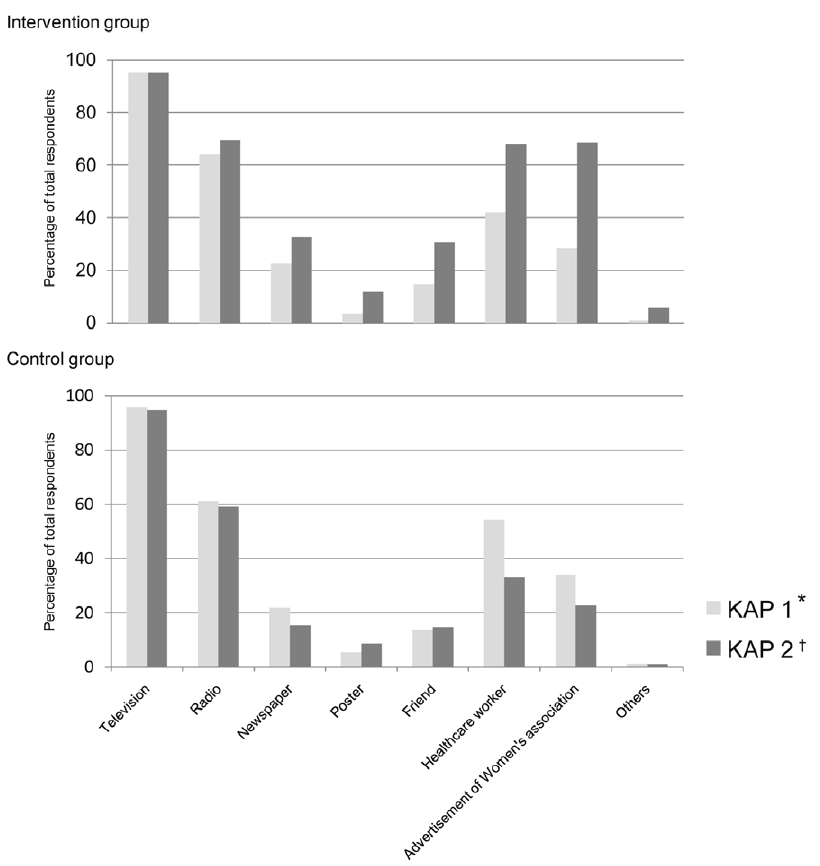
Figure 1. Information sources on avian influenza (H5N1). The changed percentage of information sources relating to avian influenza (H5N1) on *KAP 1 (pre-educational intervention survey) and { KAP 2 (post-educational intervention survey) at each